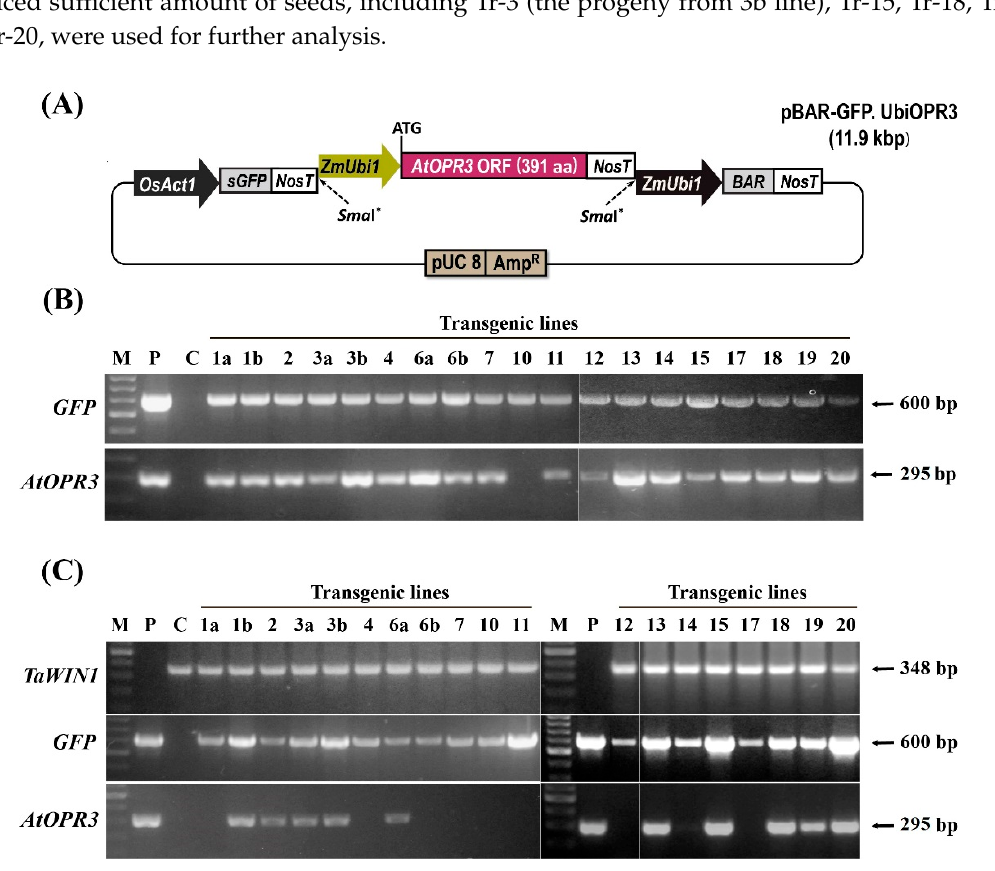
Figure 1. Generation and molecular analysis of transgenic plants. ( A ) Schematic representation of the pBAR-GFP.UbiOPR3 expression cassette used for Sar-60 transformation. OsAct1 , rice Actin 1 promoter; ZmUbi1 , maize ubiquitin 1 promoter; NosT , nopaline synthase terminator; GFP , Green Fluorescent Protein gene; BAR , BASTA resistance gene (phosphinothricin acetyl transferase); AmpR , ampicillin resistance gene. ( B ) PCR analysis performed on the genomic DNA of T0 plants for the insertion of GFP gene (upper panel) and AtOPR3 (bottom panel). ( C ) End-point RT-PCR analysis on the total RNA of T0 plants (at heading stage) for the expression of the reference gene TaWIN1 (top panel), GFP gene (middle panel) and AtOPR3 (bottom panel). Lane M, DNA ladder as a molecular weight marker; Lane P, plasmid DNA pBAR-GFP.UbiOPR3; Lane C, non-transgenic wheat plant Sar-60; Lanes Tr-1–Tr-20 represent putative transgenic wheat plants.